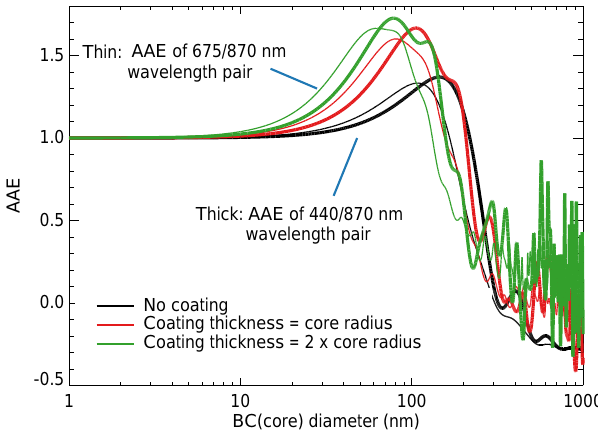
Figure 1. The Ångström absorption exponent (AAE) for BC esti- mated using Mie calculations as a function of size and for a series of coating